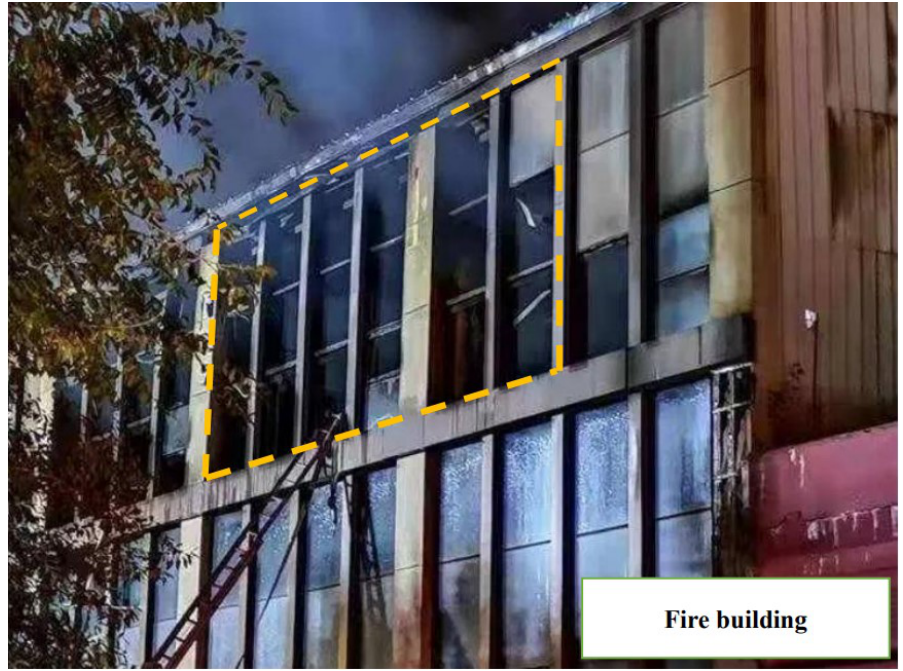
Figure 3. Electrical fires: burned buildings (picture source: [18]).